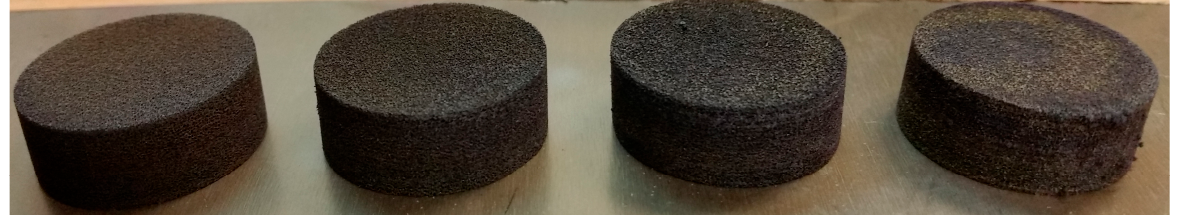
Figure 2. Dried catalyst precursors (from left to right: P1S1, P1S2, P1S3,